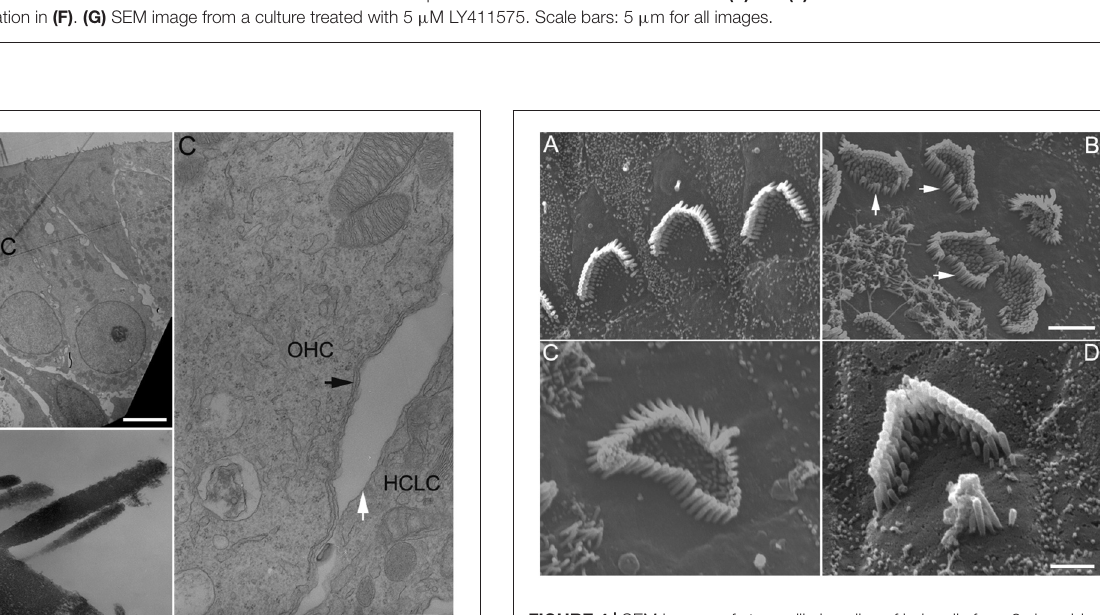
FIGURE 4 | SEM images of stereocilia bundles of hair cells from 8-day-old cultures prepared from the low apical or middle turn. (A) Hair cells without DAPT treatment. (B–D) Hair cells treated with 5 µ M DAPT. Various forms of supernumerary stereocilia were observed in existing hair cells after Notch inhibition. Scale bars: 5 µ m. Bar in (B) also applies to (A) , while bar in (C) also applies to (D) . stereocilia of endogenous hair cells maintain their shape, length and stair-case organization with some remaining microvilli in control cultures. In DAPT-treated cultures, however, signs of supernumerary stereocilia were apparent, despite the fact that the stereocilia of hair cells still maintained their length